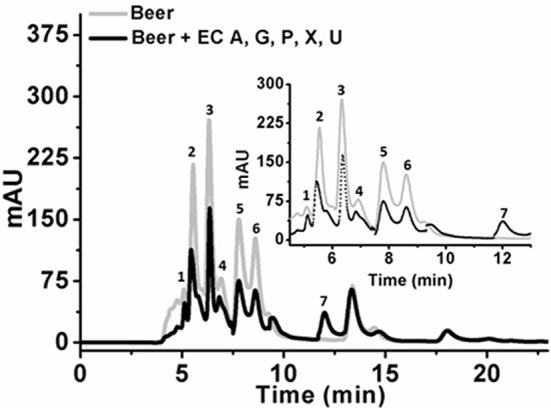
Chromatogram of beer sample before and after the enzyme cocktail treatment. The chromatogram shows purine content in beer before (dotted back line) and after KlacADA, KlacGDA, KlacPNP, KlacXanA, and uricase from Candida utilis enzyme reaction (solid gray line). Beer treated with the enzyme cocktail showed a decrease in the adenine, guanine, hypoxanthine, xanthine, and uric acid peaks. EC A (Adenine deaminase), G (Guanine deaminase), P (Purine nucleoside phosphorylase), X (Xanthine dioxygenase) cloned in E. coli, and U (commercial uricase).